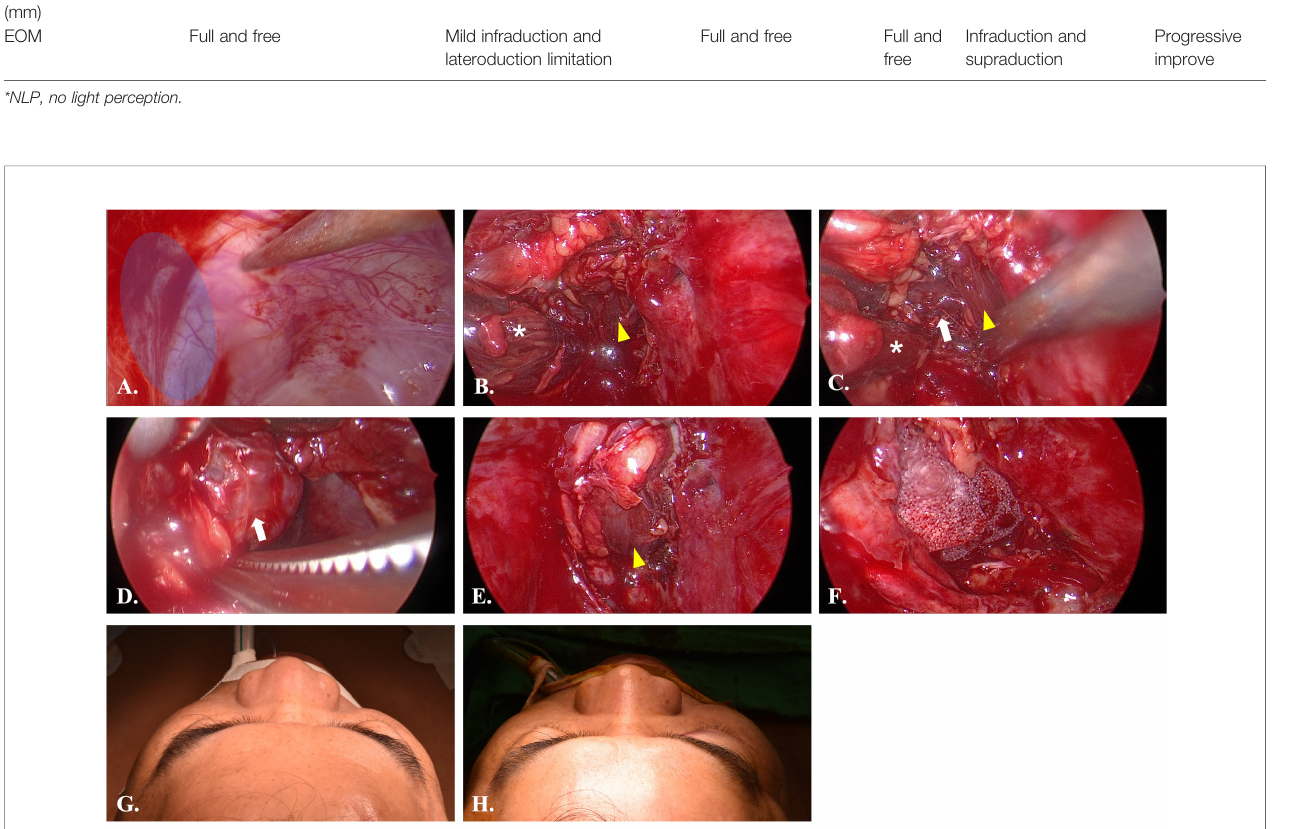
FIGURE 7 | Intraoperative views of Case 4. (A) Endoscopic view of case 4. The pointer indicated the location of infraorbital nerve. The blue area is the entry point. (B) After incision of the periorbita, the inferior rectus muscle (yellow arrowhead) and medial rectus muscle (white star) were identi fi ed. (C) Dissection between inferior rectus and medial rectus muscle to identify the lesion (white arrow). (D) Dissection of the lesion from peripheral orbital tissue. (E) Return of inferior rectus muscle to original position after removal of the lesion. (F) The orbital fl oor was repaired with porous polyethylene mesh (MEDPOR). (G) Preoperative view showed mild proptosis of right eye. (H) Postoperative view showed symmetry orbital position.